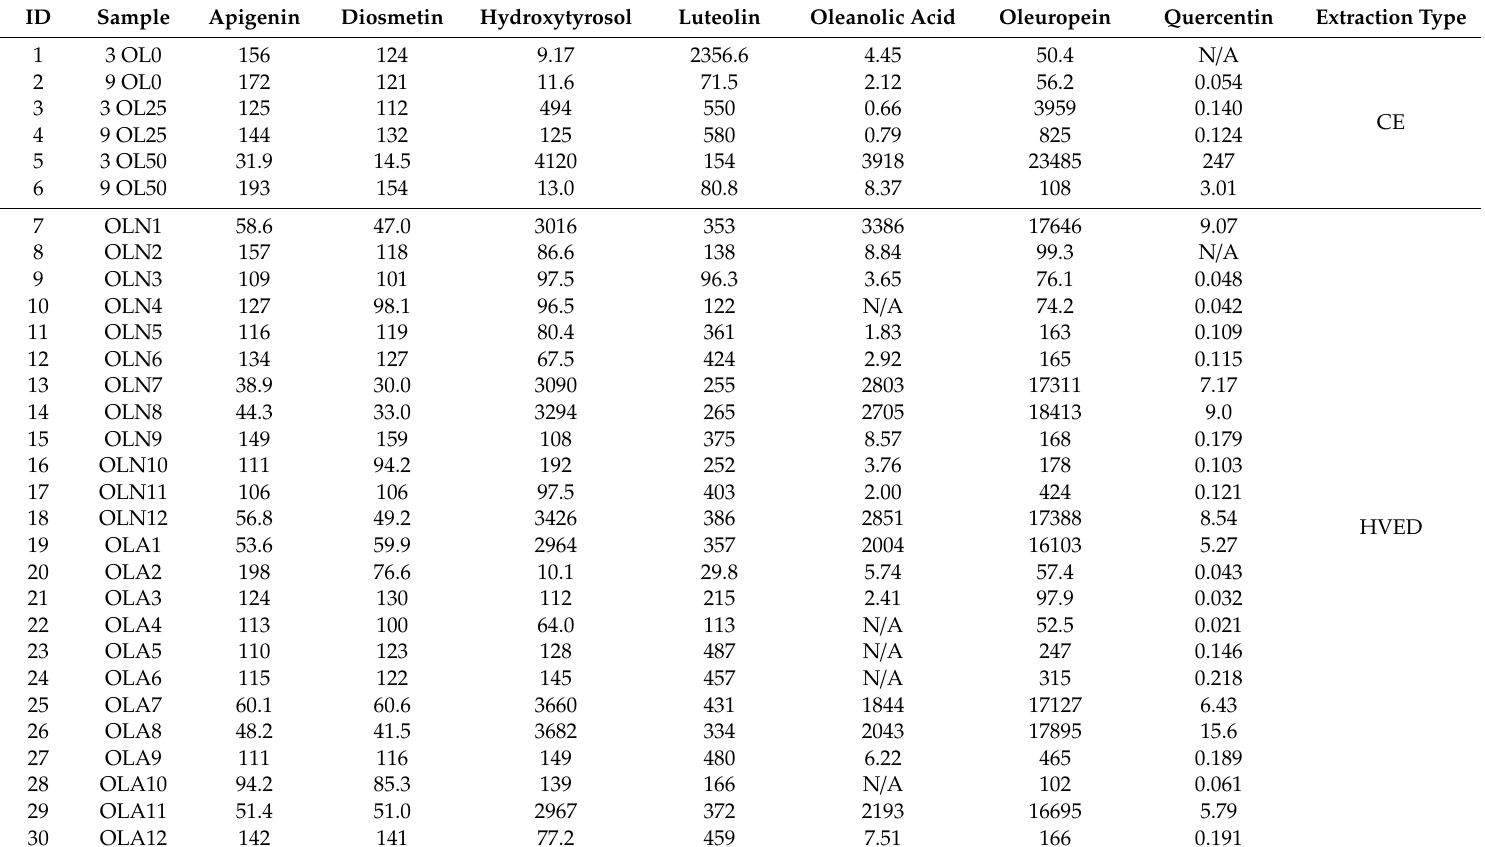
Table 4. Concentration of individual phenolic compounds in CE and HVED olive leaves extracts (OLEs) (ng /